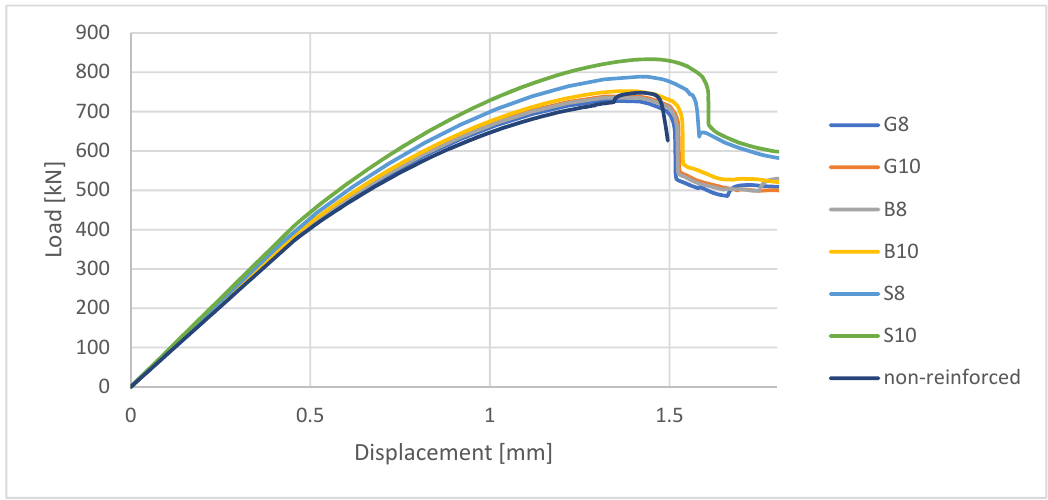
Figure 5. Load–displacement curve based on FEM analysis results.